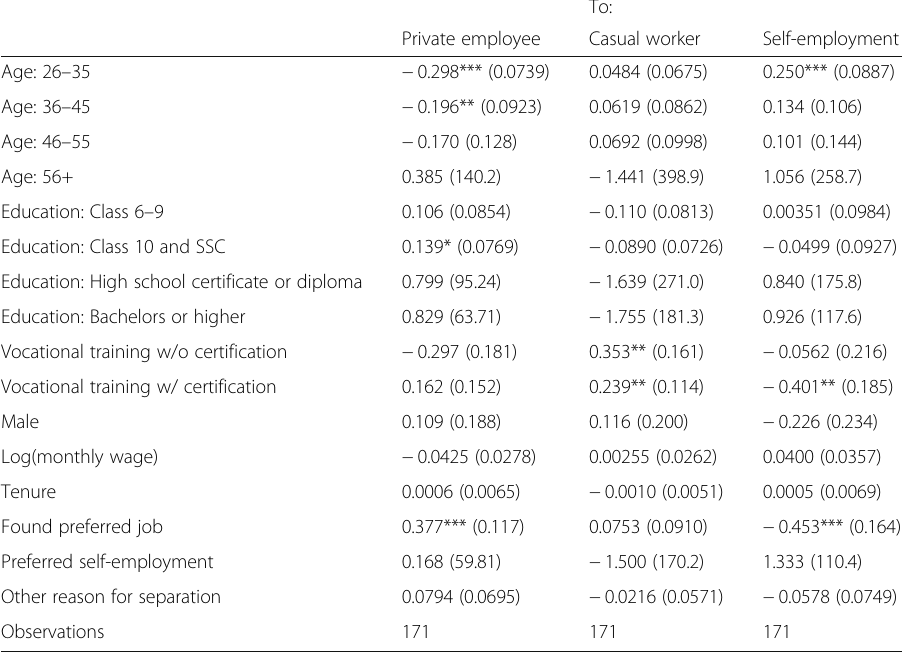
Table 13 Transitions from self-employment